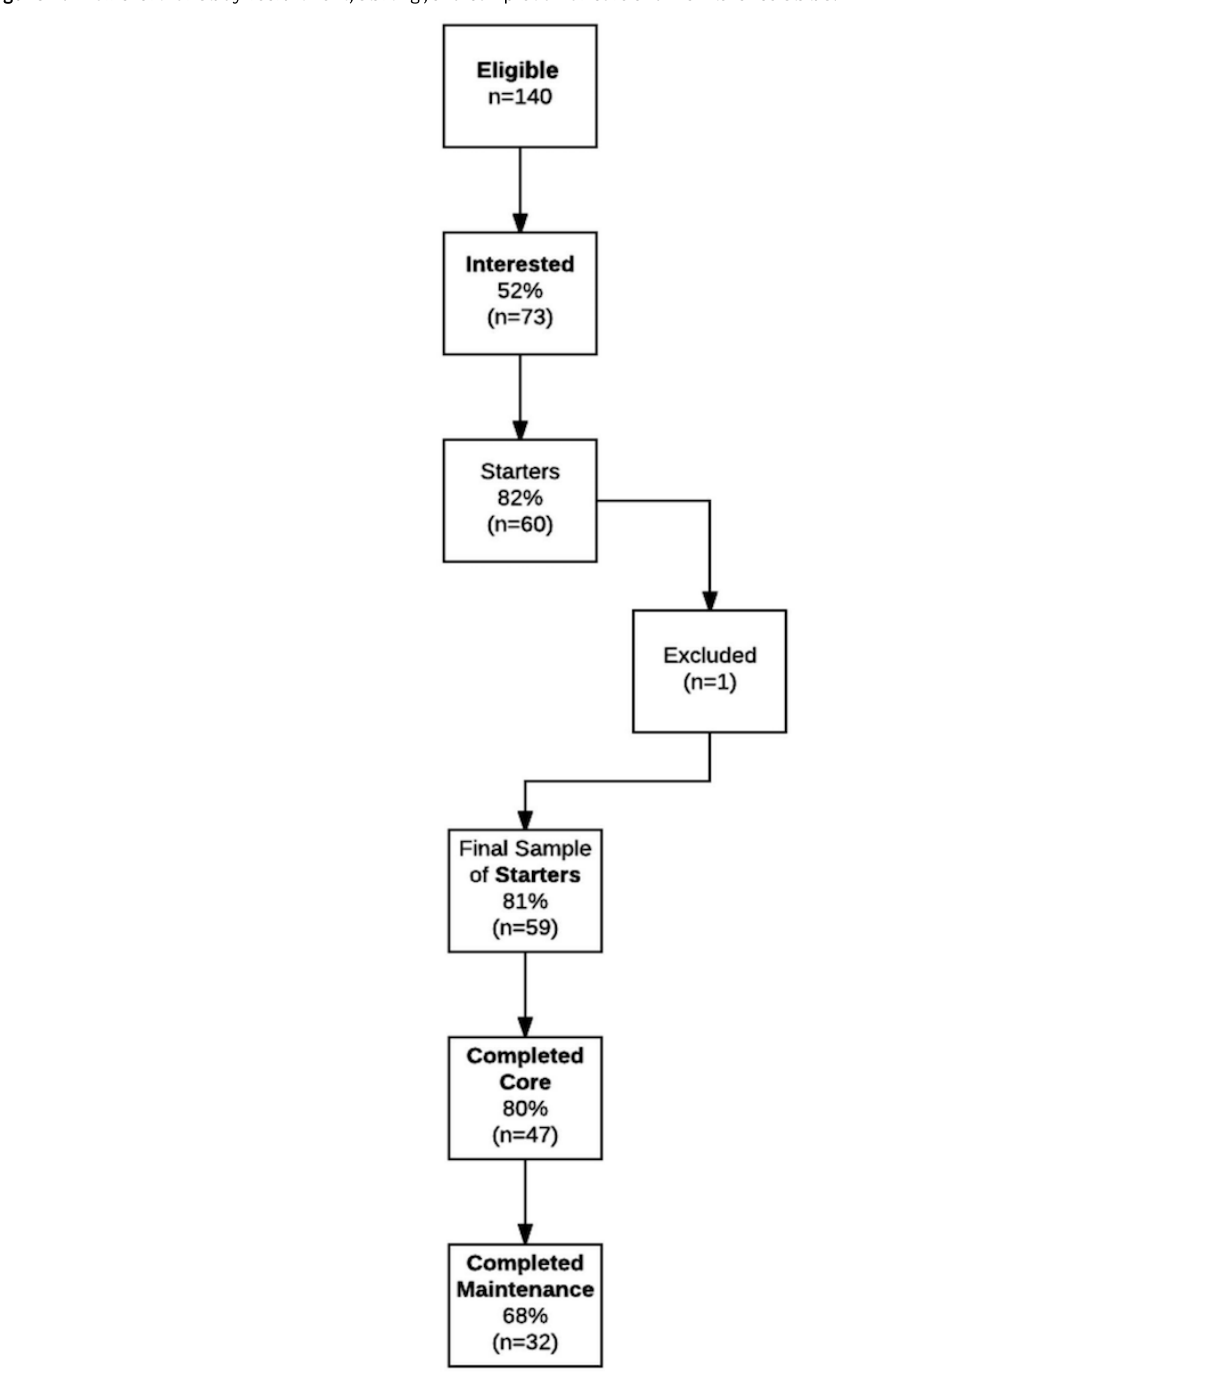
Figure 1. Flowchart for study recruitment, starting, and completion or core and maintenance